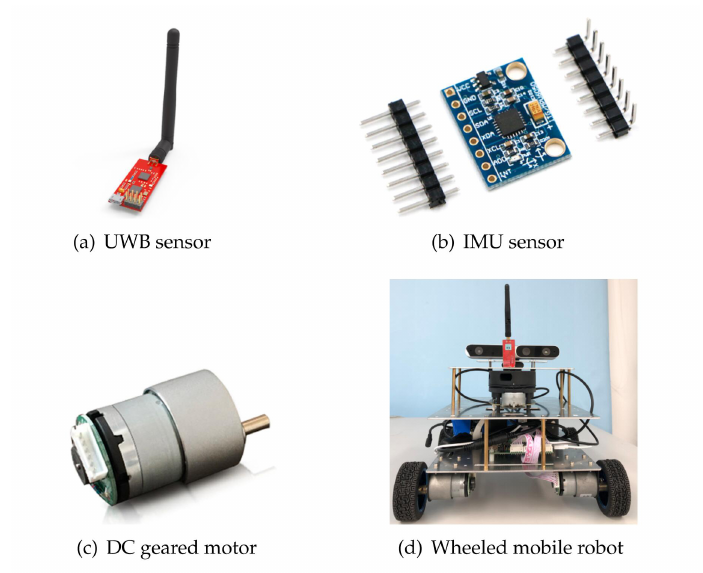
Figure 3. The sensors and the mobile robot involved in this article. ( a ) The Ultra-Wide Band (UWB) sensors(YCHIOT, Wenzhou, Zhejiang, China), which are commercial products provided by the company of YCHIOT, with the module of Mini3s; ( b ) the spatial motion sensor chip MPU6050 as the IMU sensor(Digi-Key Electronics, Thief River Falls, MN, US); ( c ) the odometer84 constructed by the DC gear motors MG513 with an encoder(Fenghua Transmission, Kunshan, Jiangsu, China); ( d ) the wheeled mobile robot platform(Ruiqu Technology, Foshan, Guangdong, China) that realizes the precise localization by carrying the above sensors.